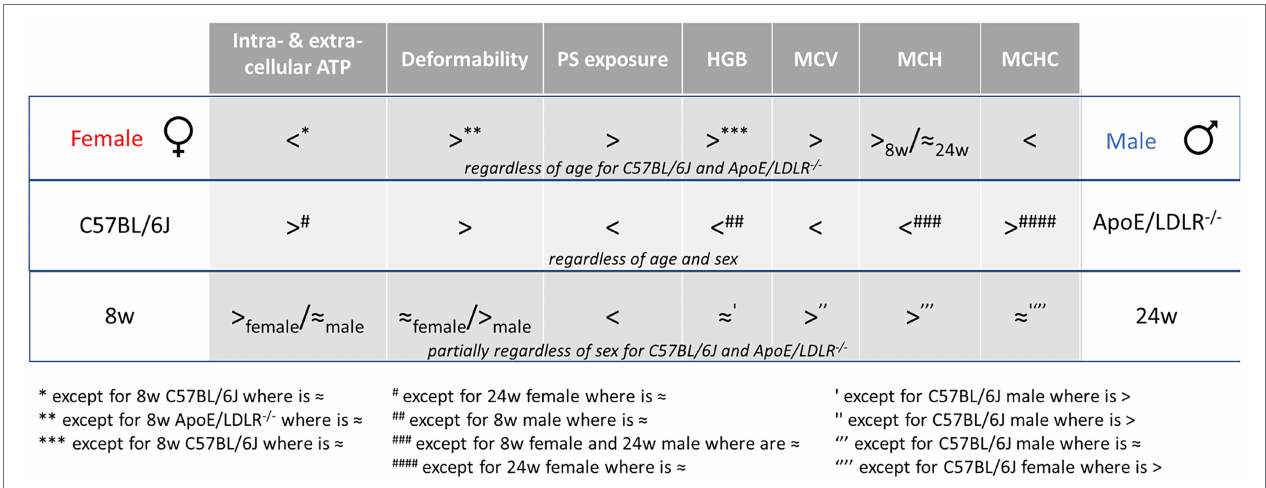
FIGURE 4 | Schematic summary of the sex-, disease-, and age-related differences in RBC parameters. “8w” and “24w” represent the age of mice as 8-week-old and 24-week-old,